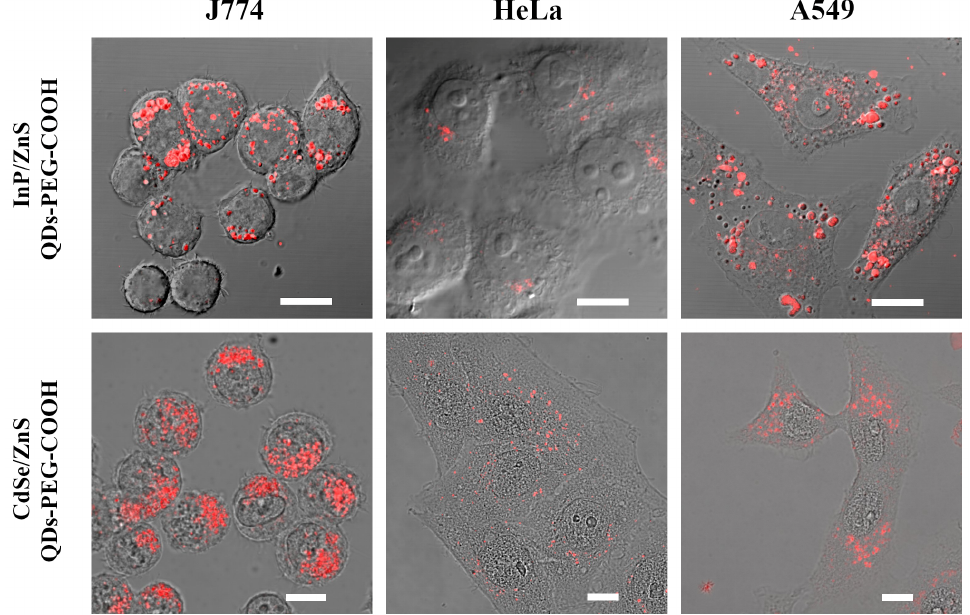
Figure 4. Visualization of InP-QDs and CdSe-QDs in J774, HeLa, and A549 cells after 4 h of incubation with QDs (20 nM). Representative images of the cells are presented. The optical section at the middle of the nucleus was taken and combined with the DIC channel. Scale bars 10 µ m.